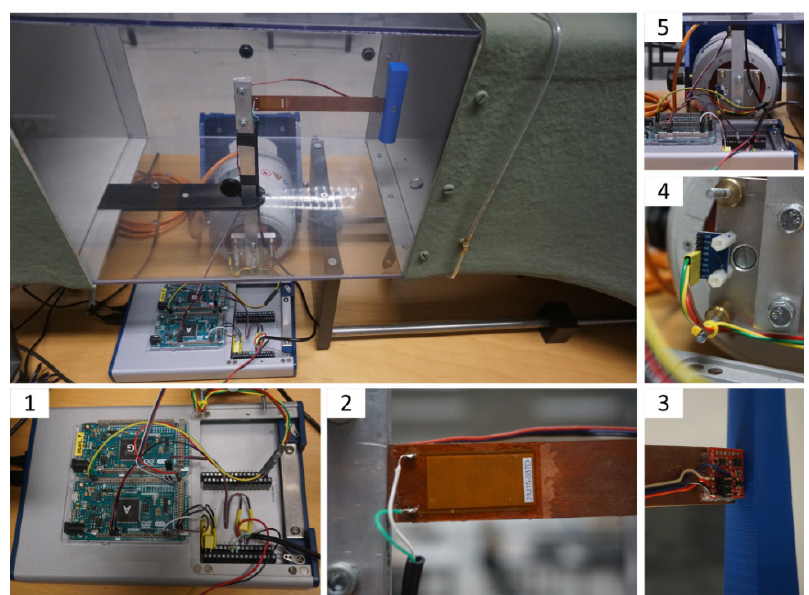
Figure 2. View of the test section and measuring system. 1, USB-6341 data acquisition board with Arduino Due; 2, piezo-element; 3, accelerometer at the tip of cantilever beam–the bluff body (its cross-section is changing smoothly from circular to square downwards); 4, accelerometer on the vibration generator; 5, vibration generator with the vertical support structure.